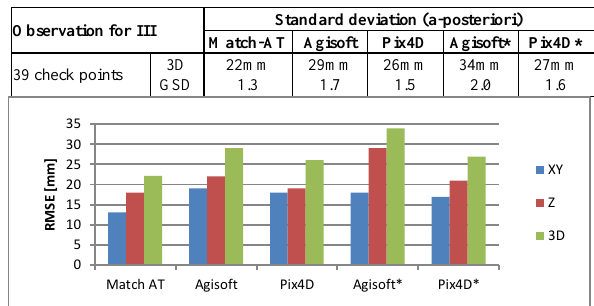
Figure 14: RMSE results at 39 check points (configuration III)